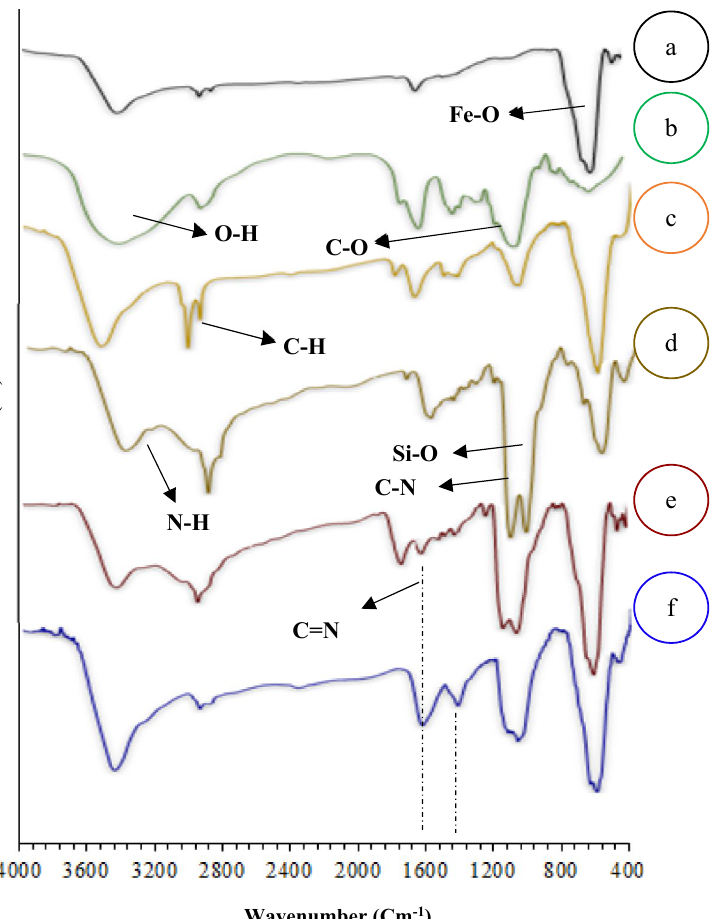
Figure 2. FT-IR spectra of ( a )Fe 3 O 4 , ( b ) Pectin , ( c ) Fe 3 O 4 @Pectin, ( d ) Fe 3 O 4 @Pectin@APTES, ( e ) Fe 3 O 4 @